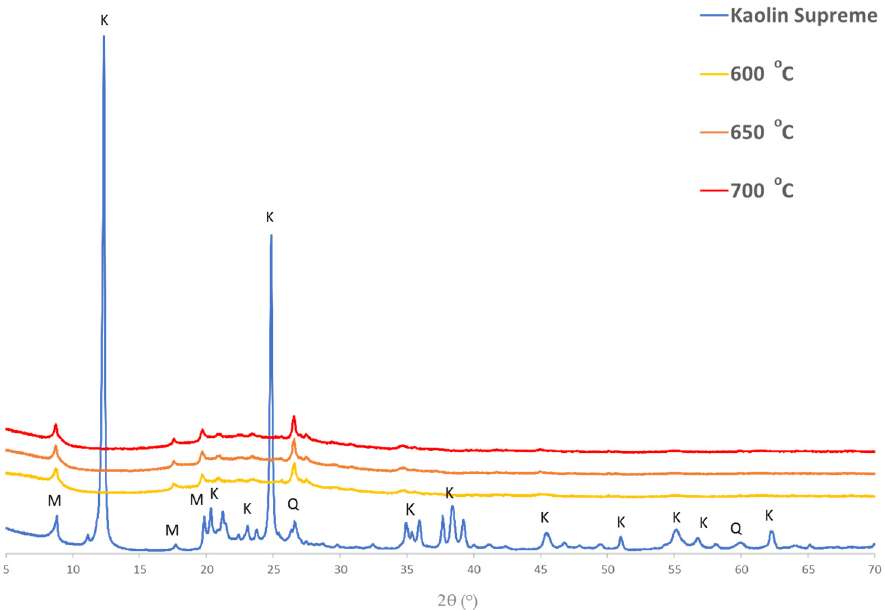
Figure 4. XRD patterns for Kaolin Supreme and its calcined products in 600, 650 and 700 °C (K: Kaolinite M: Mica minerals Q: Quartz).